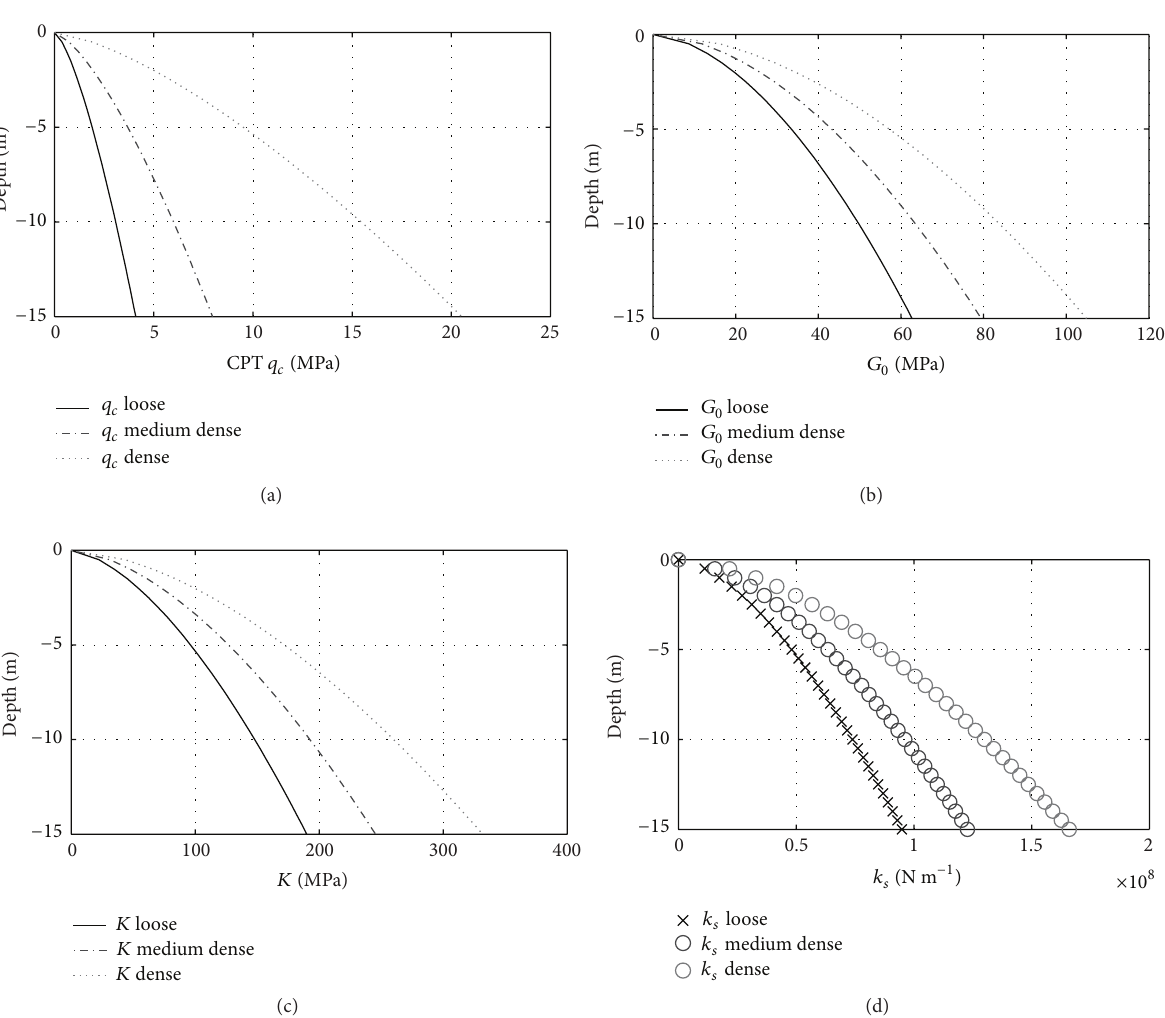
Figure 4: Example soil profiles. (a) CPT 𝑞 𝑐 profiles for loose, medium dense, and dense sand, (b) 𝐺 0 profiles, (c) modulus of subgrade reaction ( 𝐾 ) profiles, and (d) individual 𝑘 𝑠 values for loose, medium dense, and dense